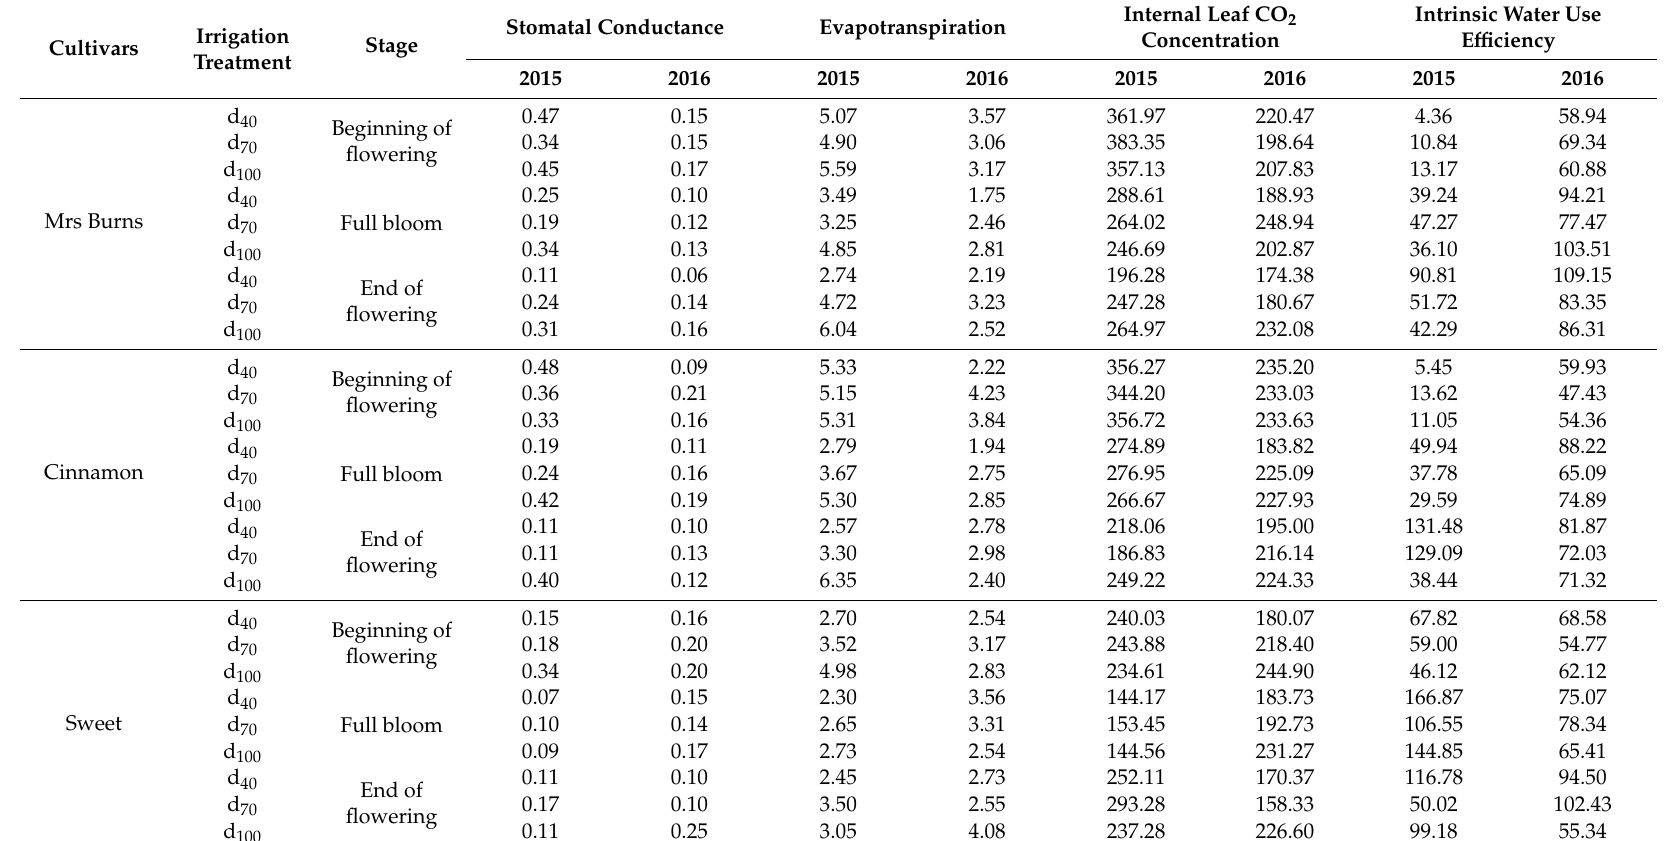
Table 4. Combined e ff ect of Years (2015, 2016), Cultivars, Irrigation levels and Stages of development on Stomatal conductance, Evapotranspiration, Internal leaf CO 2 concentration and Intrinsic Water use e ffi ciency. Data presented are mean values, where LSD is the least significant di ff erence at the 0.05 significance level.